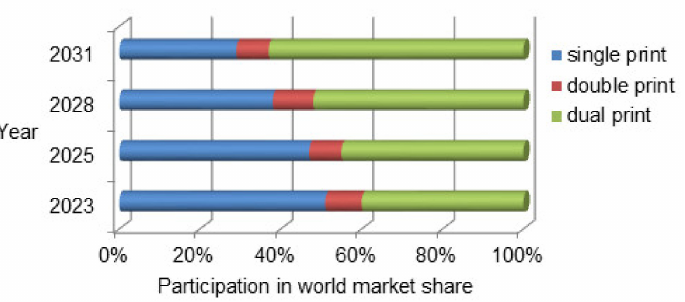
Figure 3. Prediction of the use of various front contact printing methods